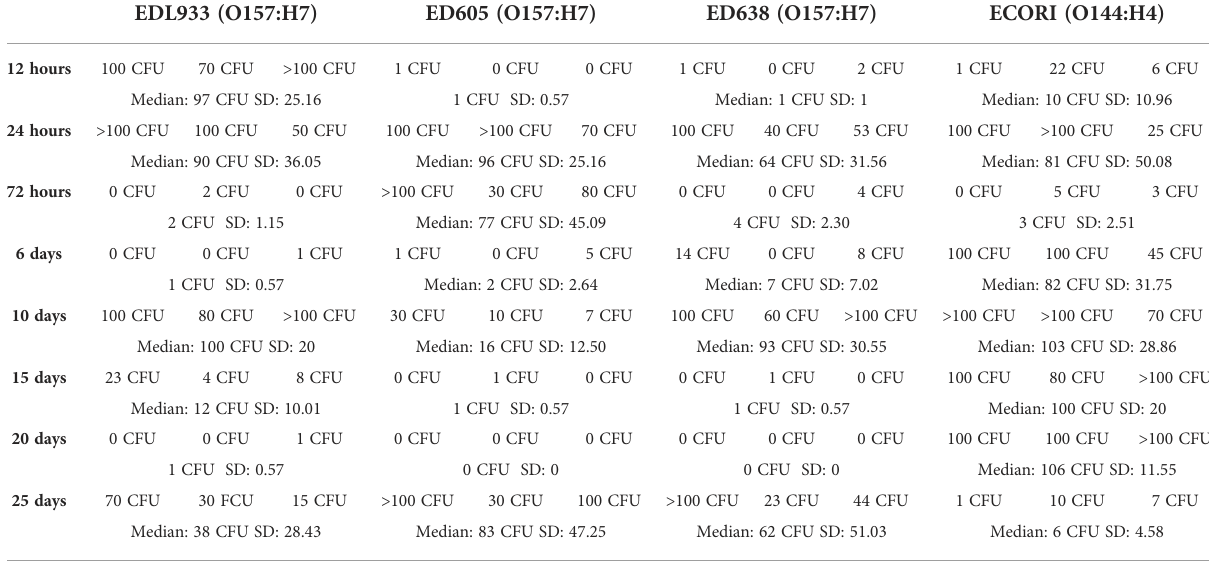
TABLE 2 E. coli (CFU) intracellular of Acanthamoeba sp. reported in triplicate. EDL933 (O157:H7)